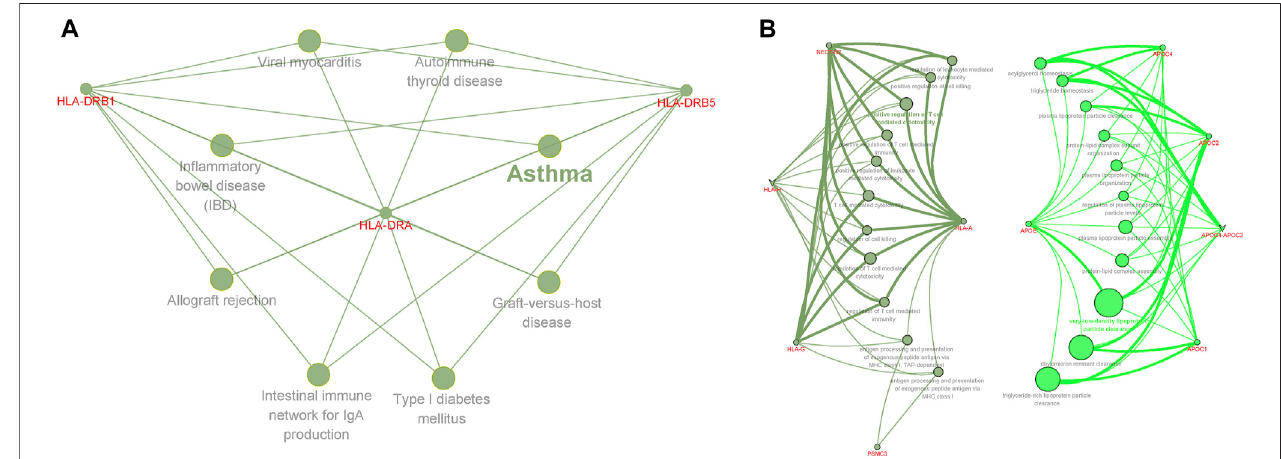
FIGURE 4 | Functional enrichment for the consensus set. Functional enrichment analysis results using the ClueGO method in Cytoscape (Bindea et al., 2009). (A) Functional enrichment analysis results of AD and insomnia in KEGG pathways. (B) Functional enrichment analysis results for AD and sleep duration in GO terms. Each dot represented a gene, a GO term, or a KEGG pathway. Dots of the same color were considered to be from the same functional group by ClueGO annotation. Gene names were highlighted in red. Each edge indicated the gene was a component gene of the linked GO term or KEGG